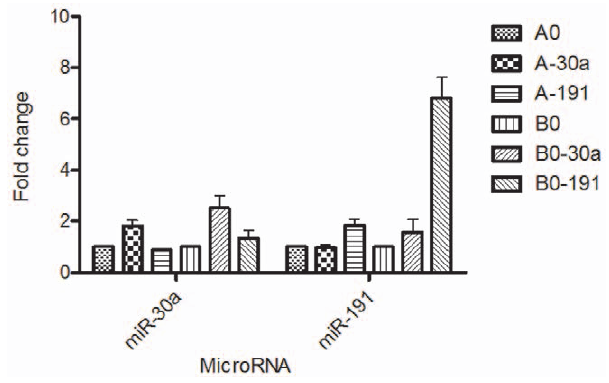
Figure 1. Quantitative RT-PCR for confirming over-expression of miR-30a in A-30a and B-30a, and of miR-191 in A-191 and B- 191 cell lines, respectively. Expression is normalized to control cell lines (A0 or B0).